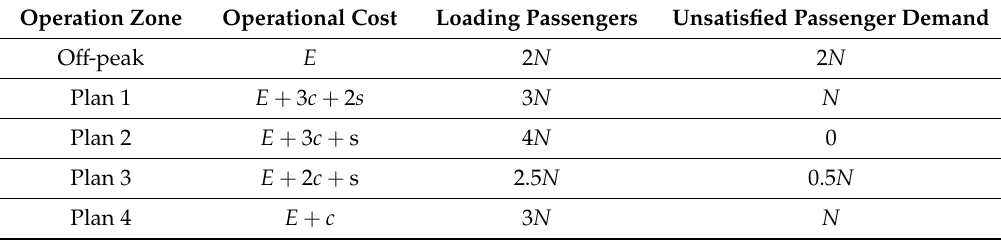
Table 2. The comparison of plan 1, plan 2, plan 3, and plan 4.